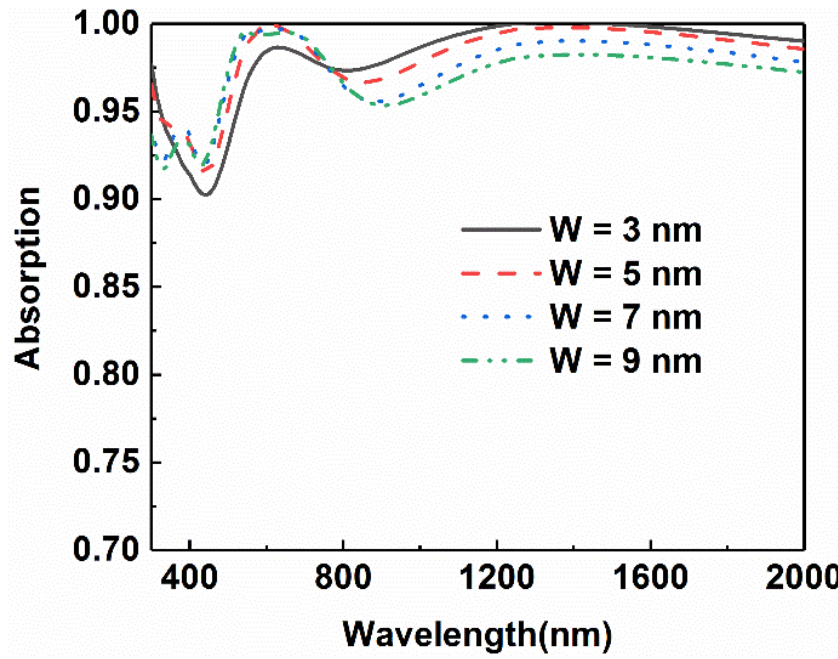
Figure 8. Comparison of light absorption of the absorbers with different arm widths of the cross.